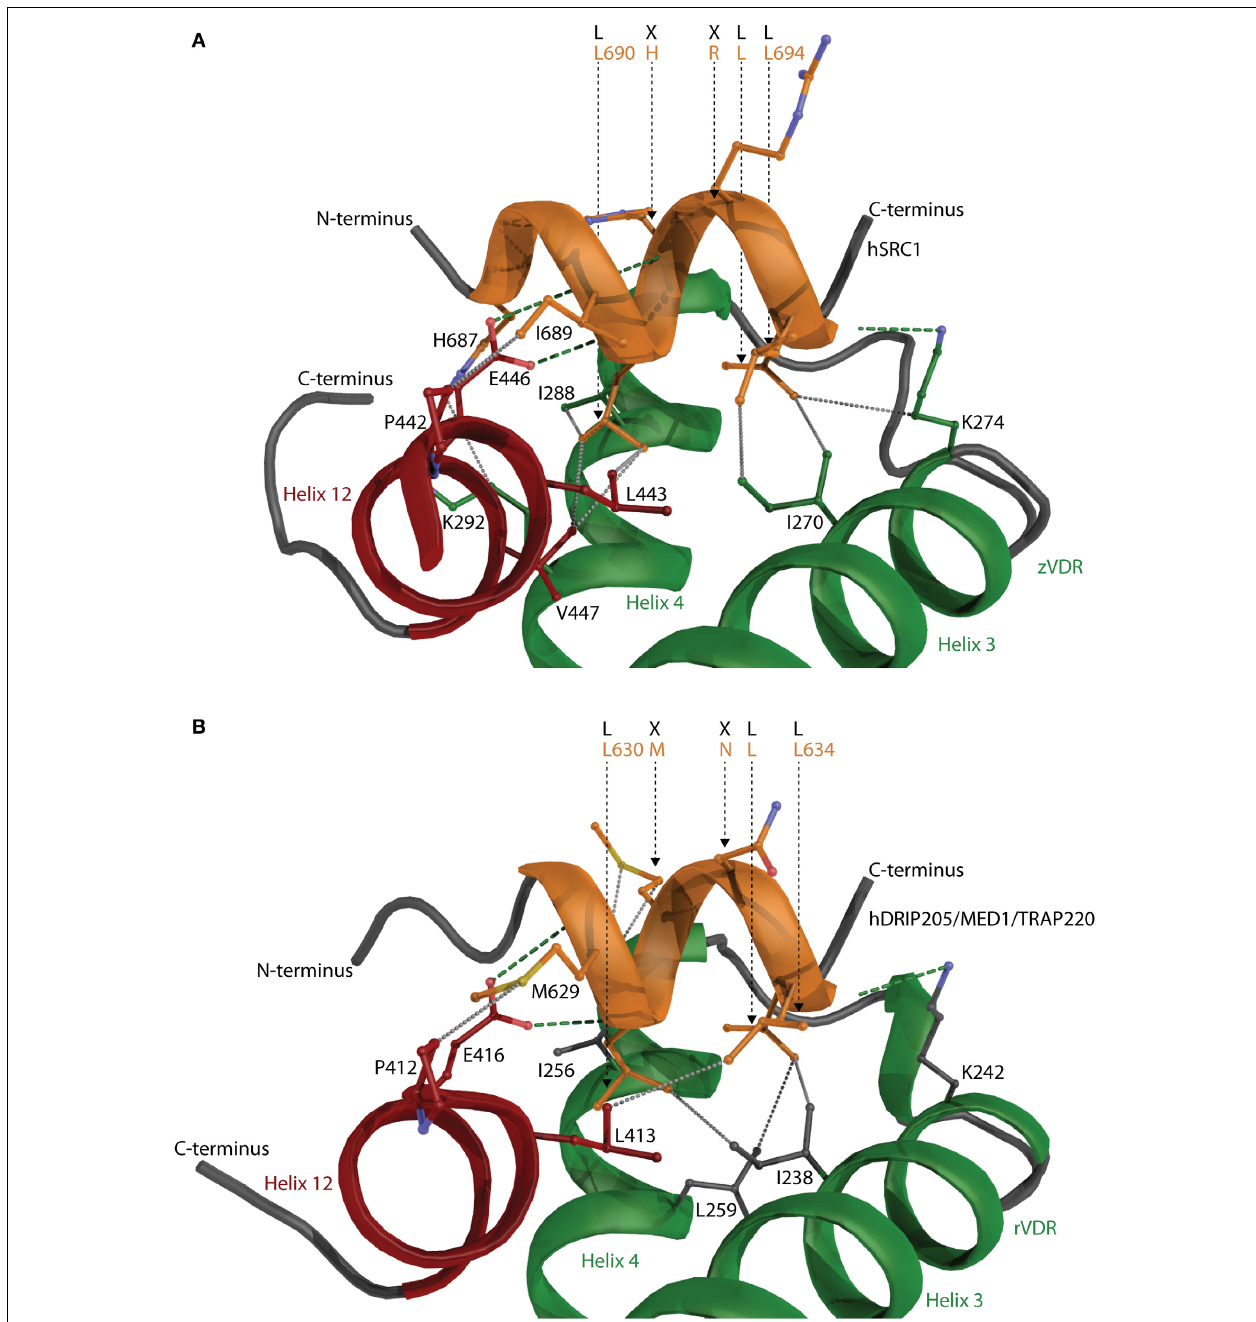
FIGURE 8 | The interaction of coactivator peptides with VDR. Peptides derived from (A) steroid receptor coactivator 1 (SRC1) with zVDR and (B) mediator complex subunit 1 (MED1/DRIP205) with rVDR shown. SRC1 and MED1 is shown in orange and VDR in green. Helix 12 is highlighted in red.